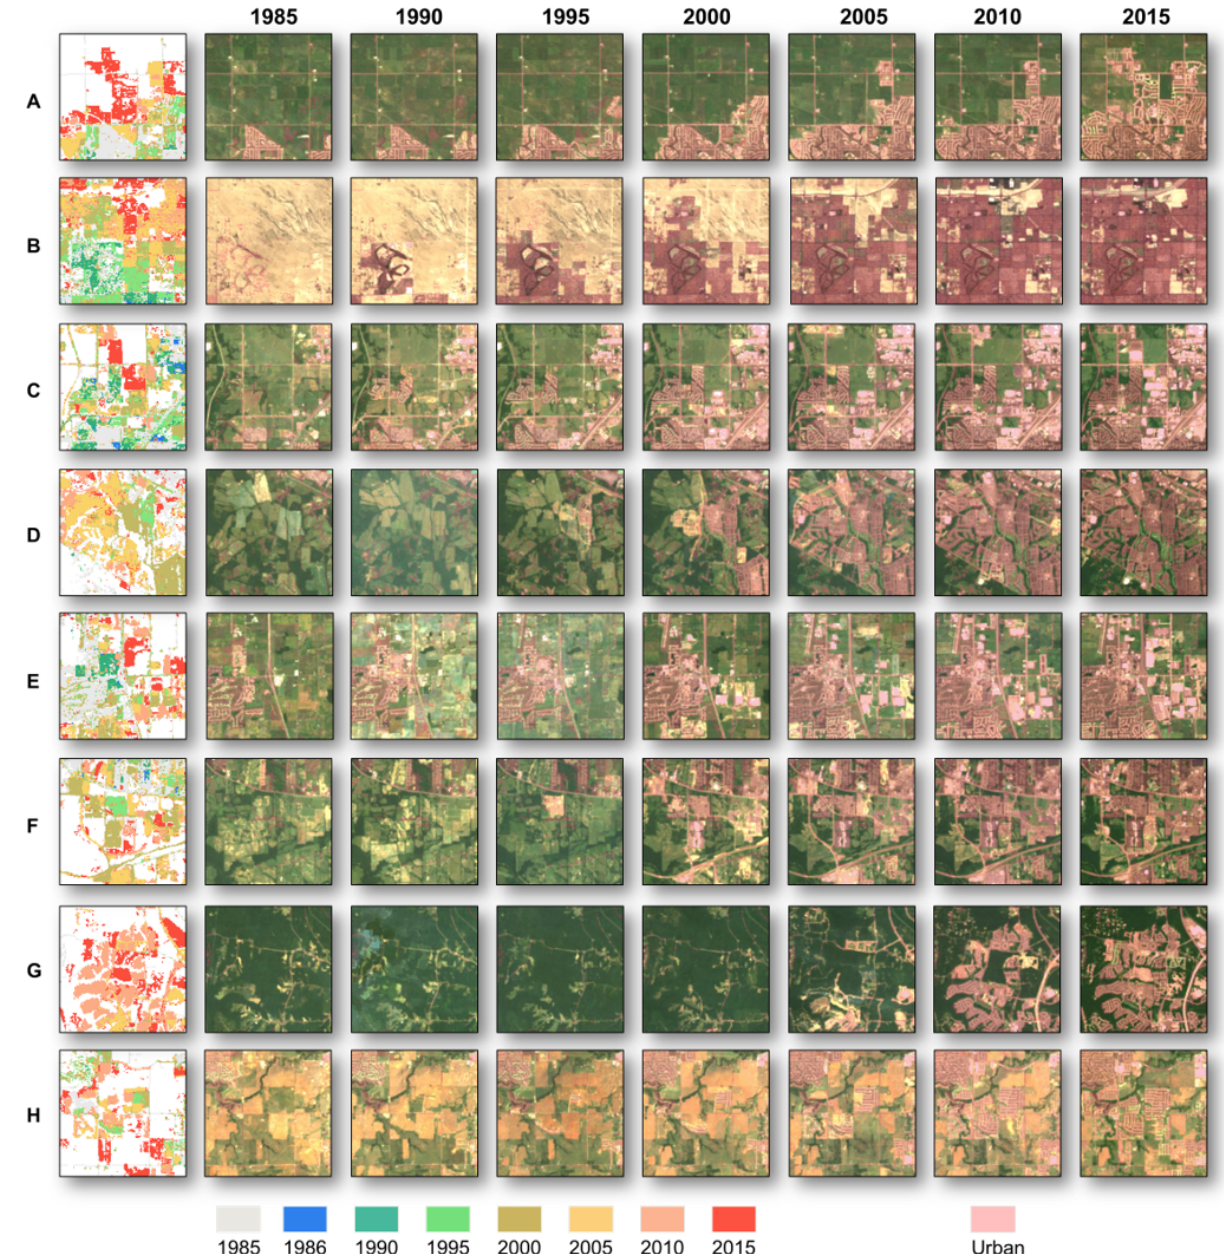
Figure 11. Comparison of annual urban dynamics with Landsat images. The geographic location of each region (A–H) corresponds to the black frames in Fig. 10. The spatial extent of each region is 25km 2